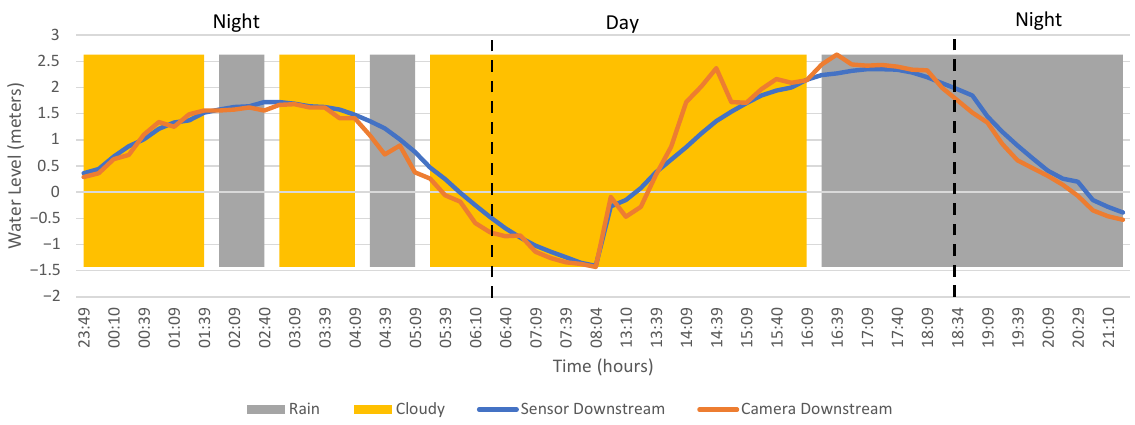
Figure 11. Water level with reference to MSL; scenario 3 displays normal fluctuations in weather conditions.